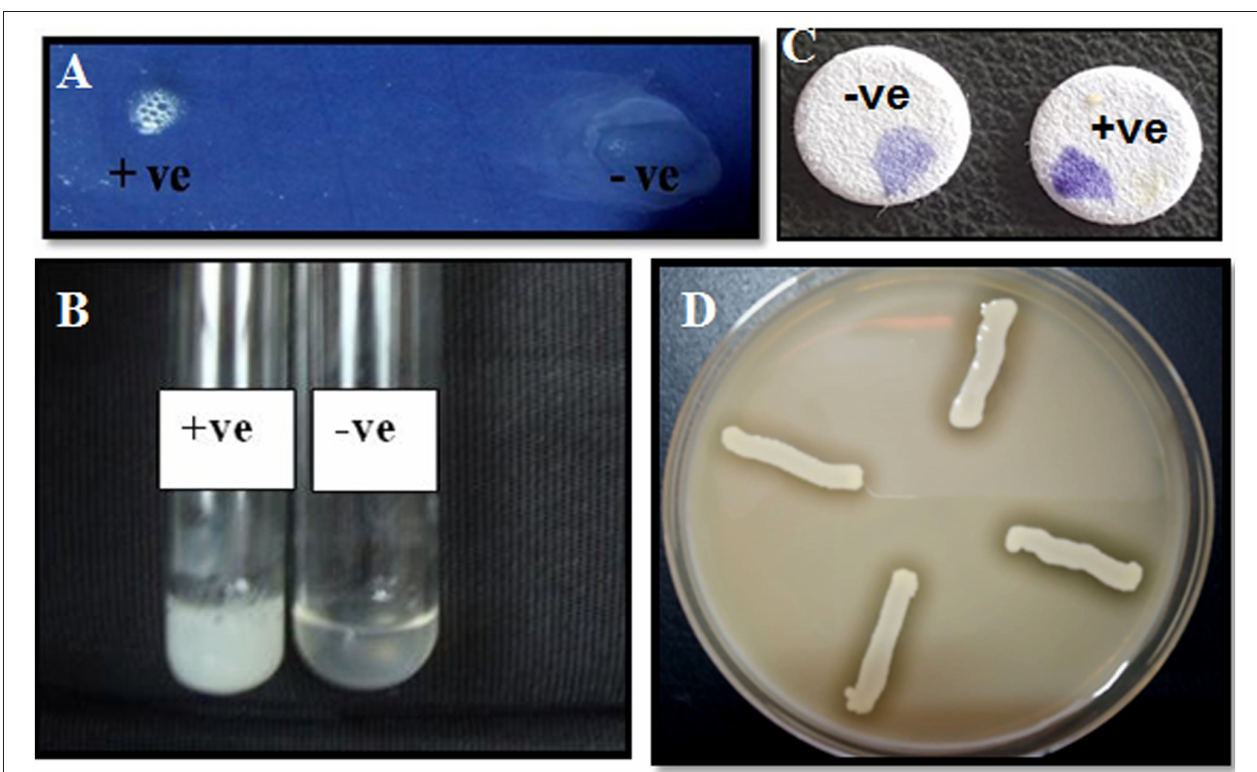
FIGURE 2 | Characterization of bacterial isolates by biochemical tests. (a) Catalase test: Effervescence seen on the addition of S. aureus to 3% H 2 O 2 ; (b) tube coagulase test: coagulation observed for S. aureus ; (c) oxidase test—development of purple color on disc within 10s of adding the organism; (d) halo zone observed for S. aureus on DNase agar.